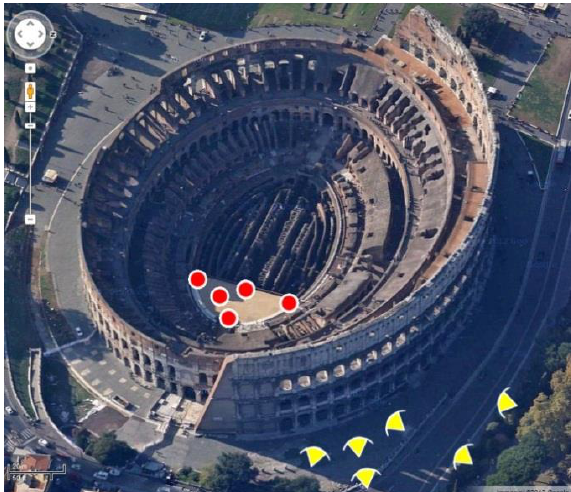
Figure 6. Acquisition scheme, inside (red stations) and outside (yellow stations) the